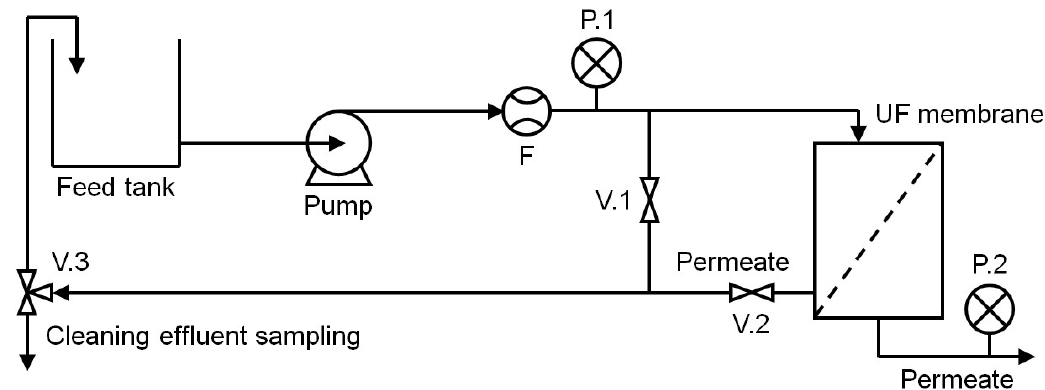
Figure 1. Schematic of pilot-scale UF system.